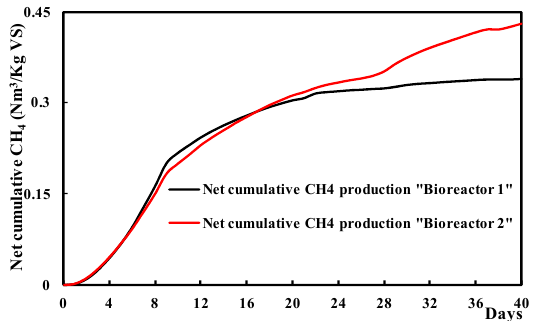
Figure 7. Net cumulative bio-methane production of the two bottles.